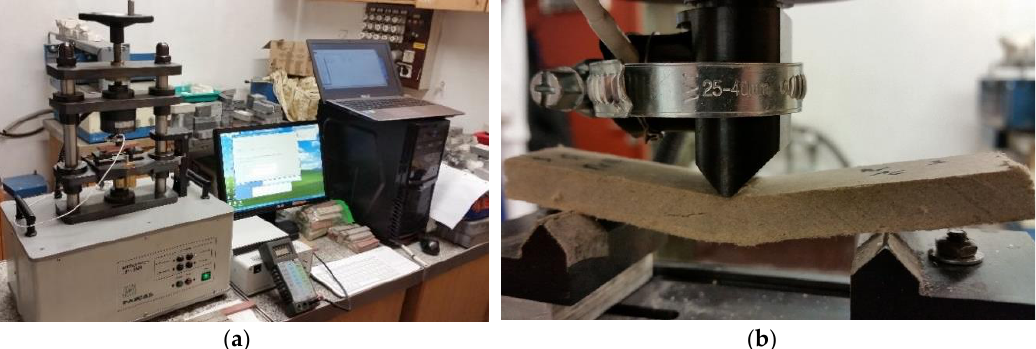
Figure 5. Stand for measuring acoustic emission during a three-point bending test: ( a ) instrumentation setup, ( b ) fiber cement board specimen during testing.